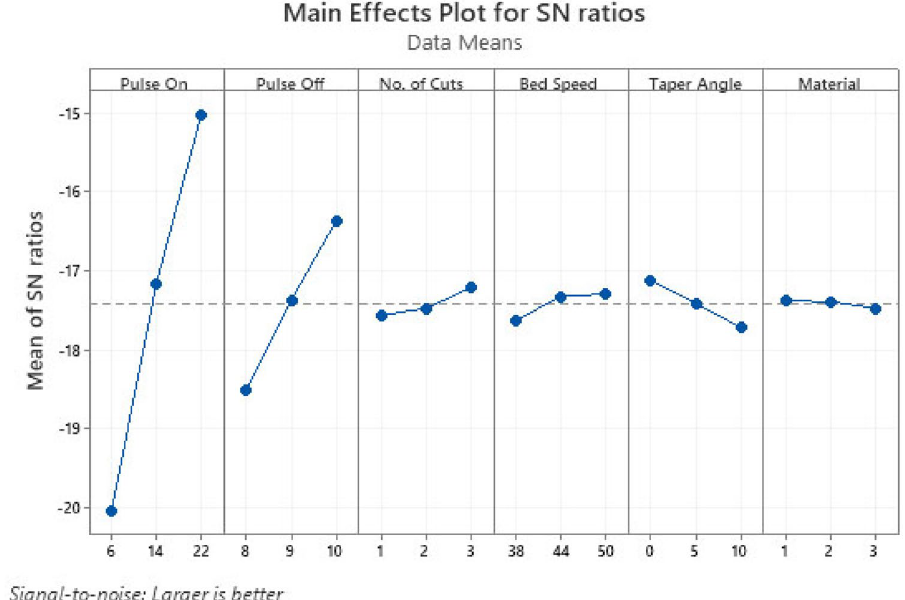
Fig. 9 Main effects plot for S/N ratios of